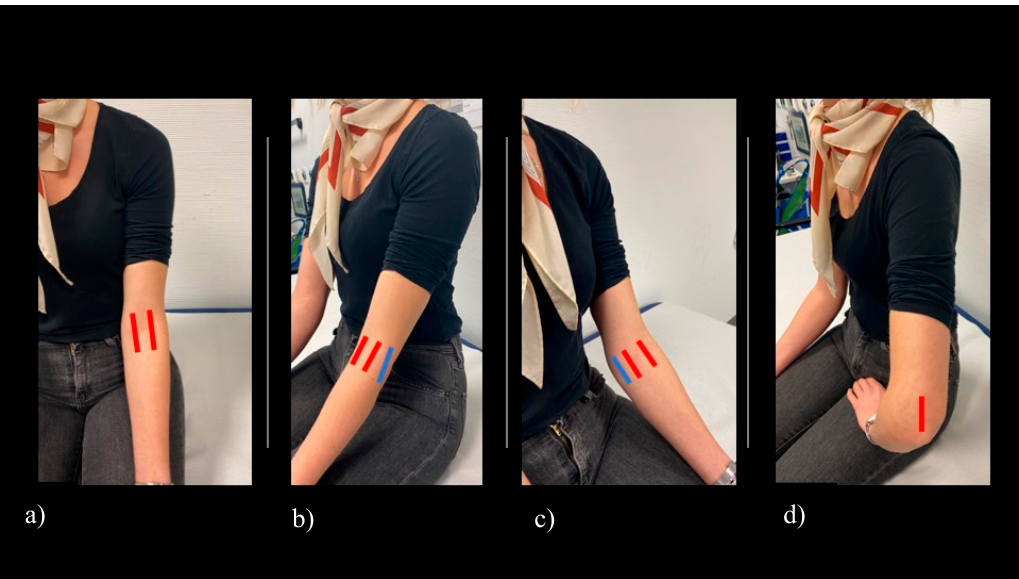
Figure 1. Scanning planes of the elbow applied in this study. ( a ) Humeroulnar and humeroradial longitudinal sections (displayed in red color), ( b ) longitudinal section over the lateral epicondyle (displayed in blue color), ( c ) longitudinal section over the medial epicondyle (displayed in blue color), ( d ) posterior longitudinal section (displayed in red color).